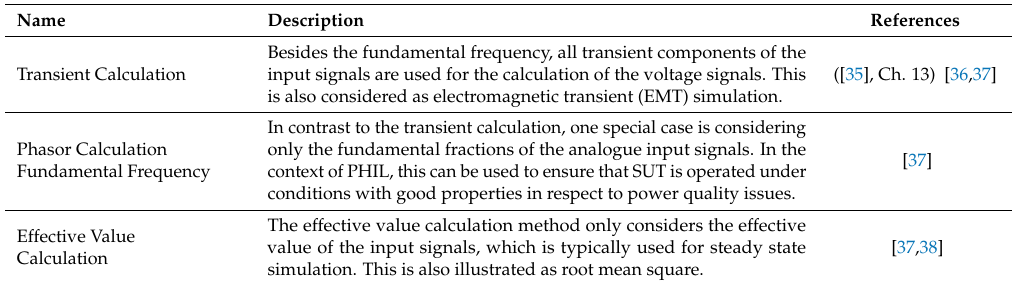
Table 1. Comparison of different methods for the calculation of energy transfer and control processes.